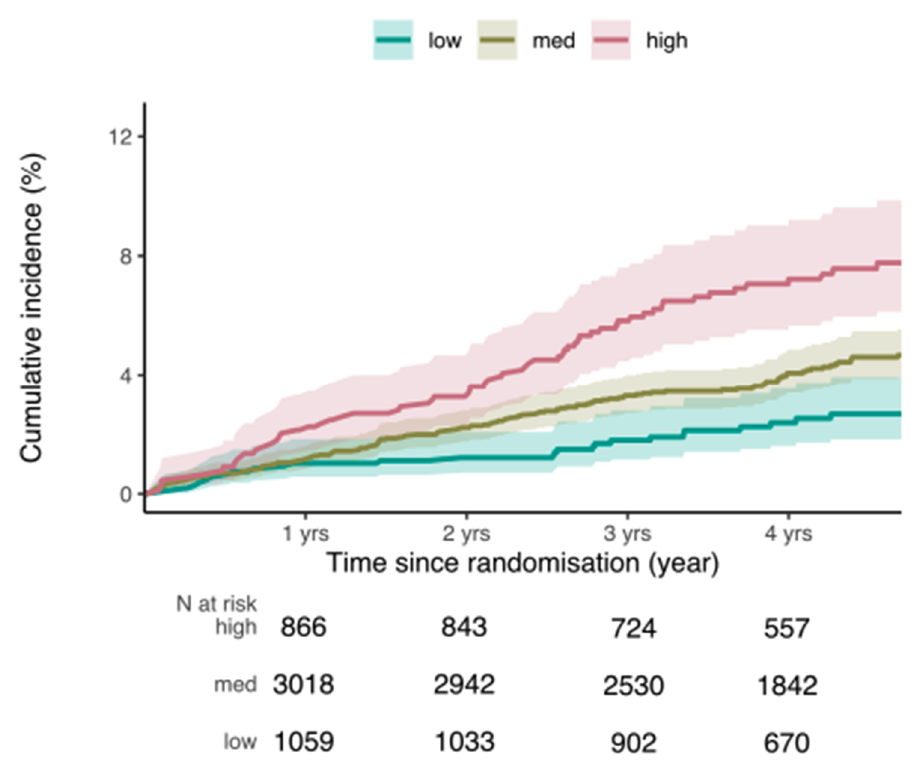
Figure 1. Competing risk survival curves for incident prostate cancer by PRS group. Low risk = PRS 0–20% (blue line); medium risk = PRS > 20–80% (yellow line); high risk = PRS > 80–100% (red line). Cumulative incidence of prostate cancer risk accounting for competing risk (death) is plotted, with groups stratified according to PRS group. Table 3. Multivariable Cox regression model for prostate cancer incidence—subgroup analysis for men aged 70–74 years. Incident prostate cancer in participants with age at randomisation between 70 and 74 years (126 clinically confirmed cases during the ASPREE trial, excluding all prevalent cases)